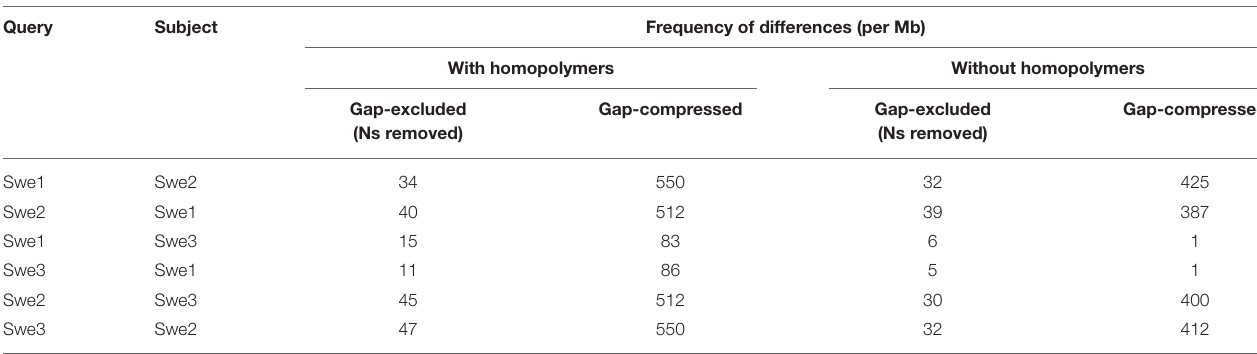
TABLE 1 | Differences between the Swe